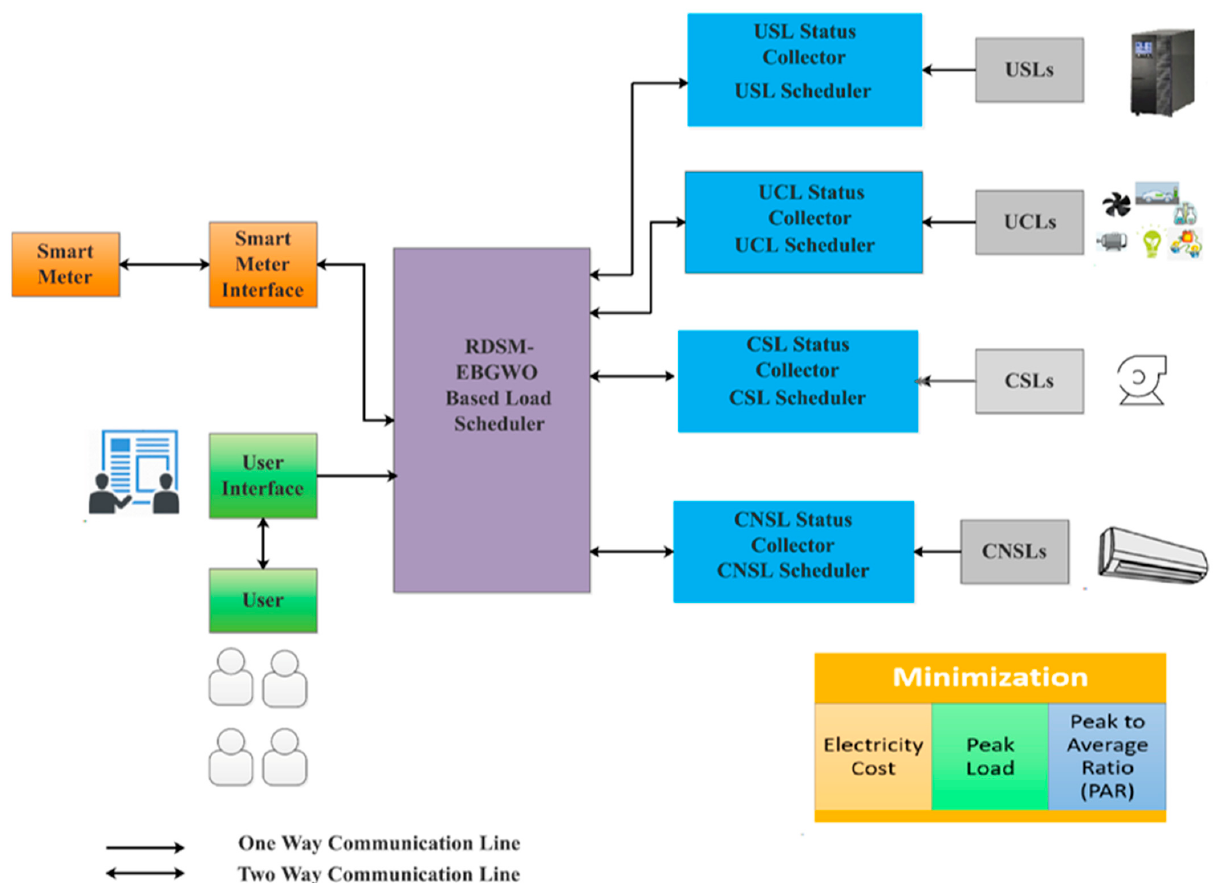
Figure 2. Architecture of the proposed RDSM–EBGWO.